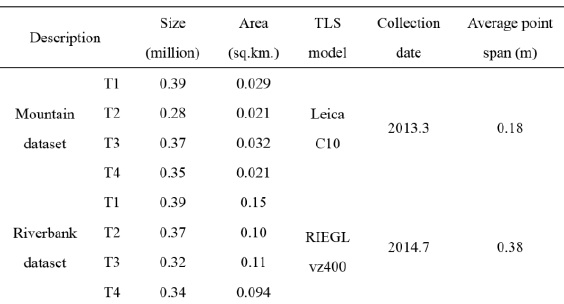
Figure 4. Two TLS datasets of complex scenes: (a)-(d) T1 to T4 stations of mountainous area, (e)-(h) T1 to T4 stations of riverbank area. Table 1. Detailed information of